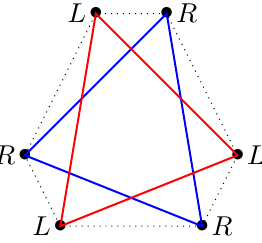
Figure 18. Rigged ( N; 1) brane as two chiral branes, stabilized by chiral Higgs (red &